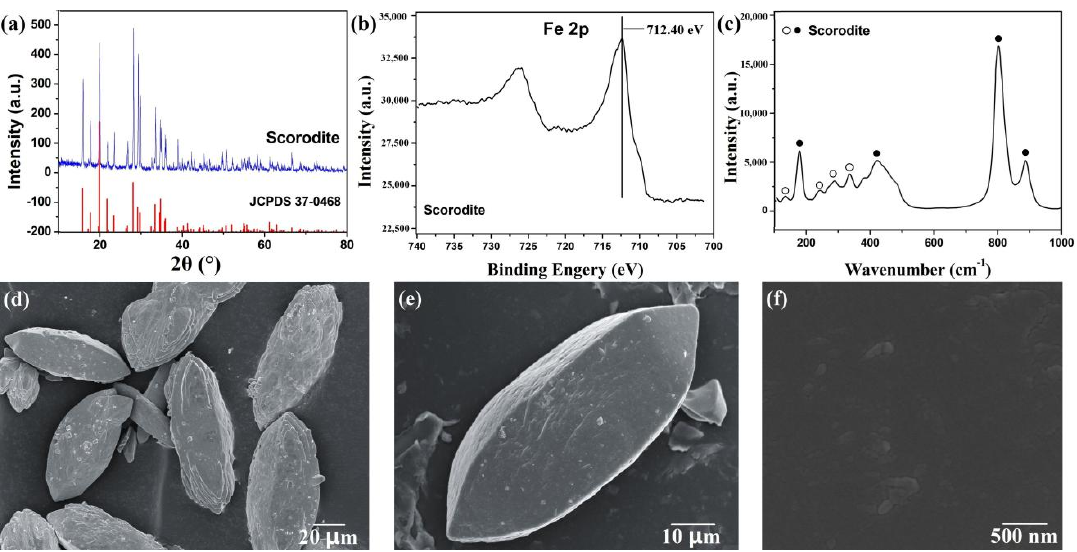
Figure 1. ( a ) X-ray diffraction (XRD) pattern, ( b ) X-ray photoelectron spectroscopy (XPS) spectrum, ( c ) Raman spectrum, ( d–f ) SEM images of the as-synthesized scorodite.